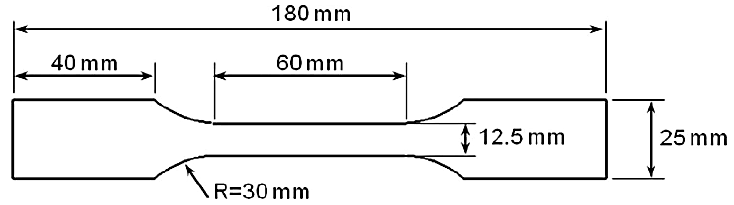
Figure 2. Geometry of the tensile specimens ( t = 3 mm).